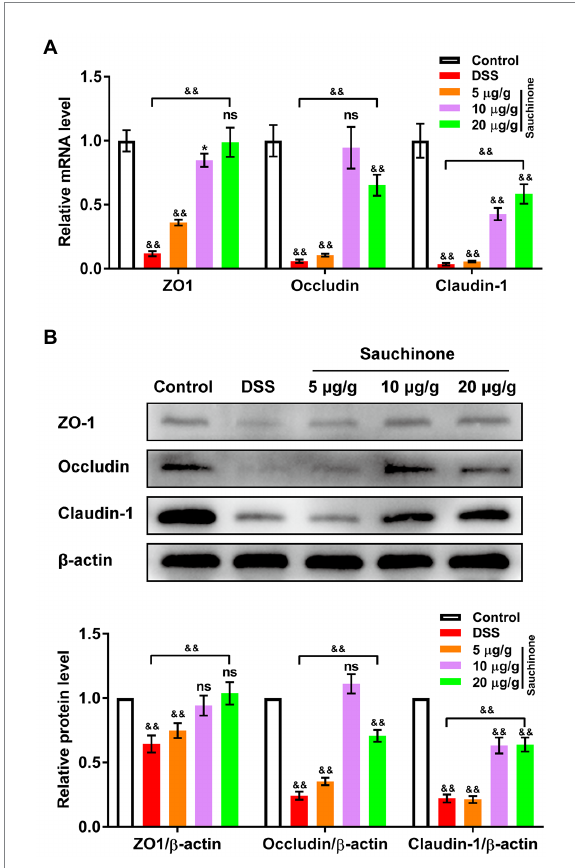
FIGURE 3 Effects of sauchinone on colonic mucosal barrier damage in DSS-induced UC mice. The expression levels of tight junction proteins (ZO-1, occludin, and claudin-1) were detected by (A) qPCR and (B) western blot. Data are expressed as mean ± standard deviation. * p < 0.05 and && p < 0.01 vs. corresponding control, ns indicates no significant difference; n =